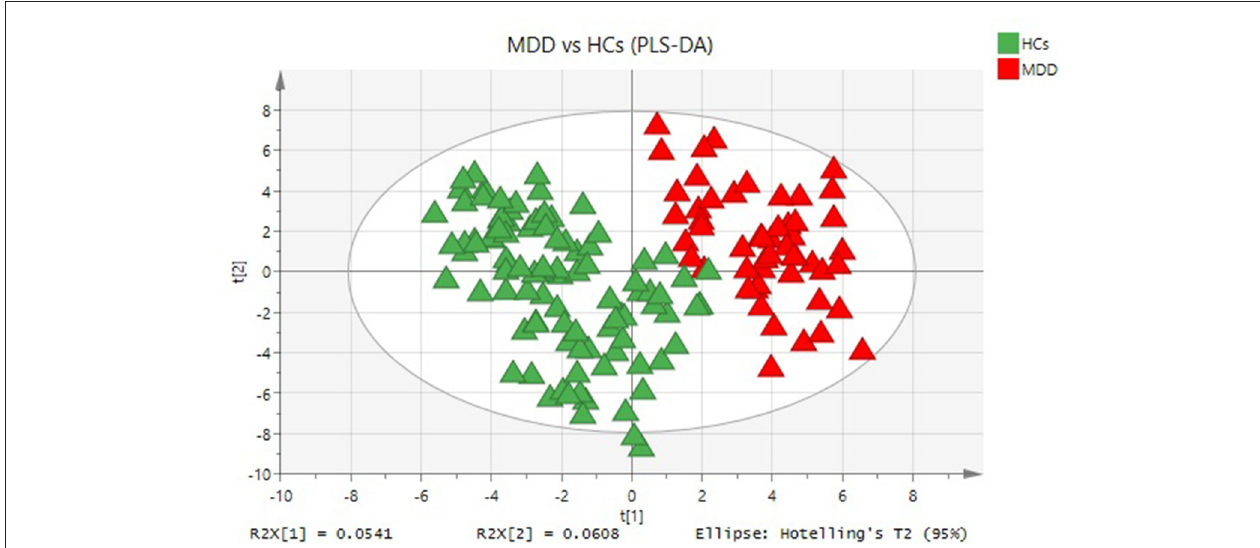
FIGURE 1 | Metabolomic analysis of plasma samples from all participants. PLS-DA model indicates a significant difference between MDD (red triangle) and HCs (green triangle).